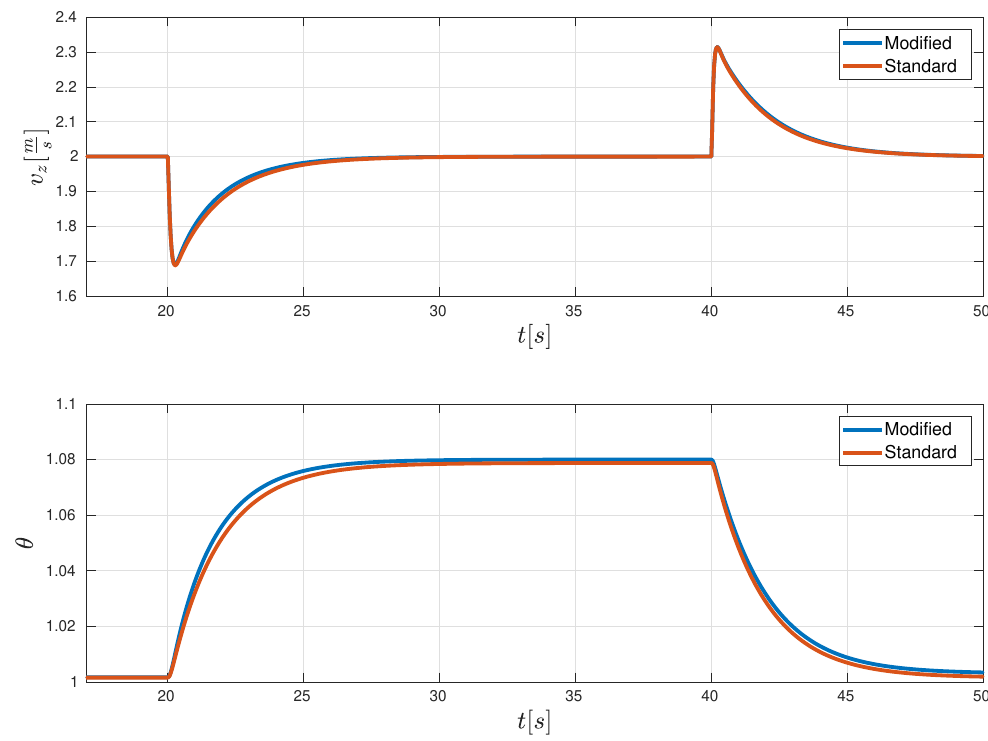
Figure 6. Simulation of the difference of the additive PID controller.